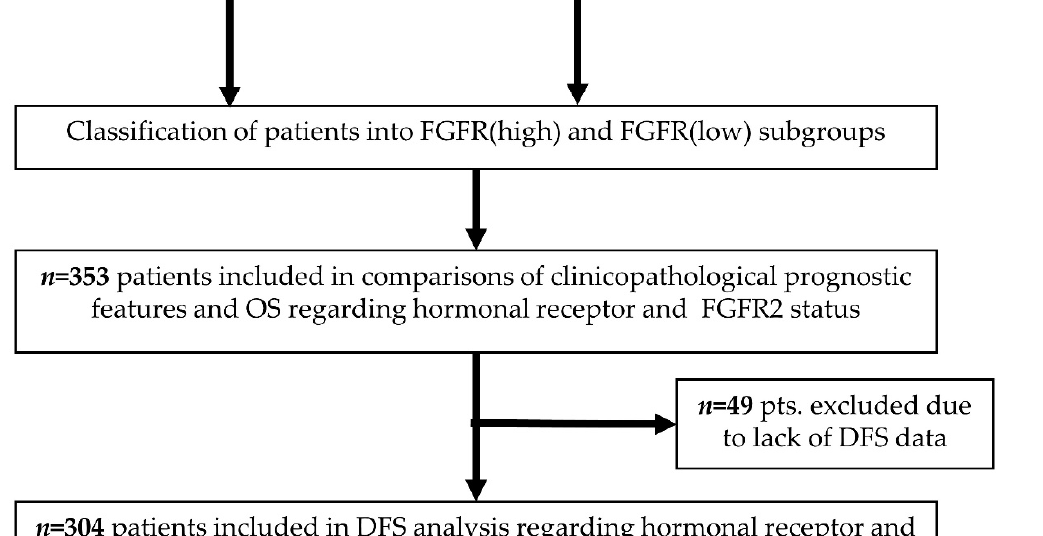
Figure 1. Flowchart of the study design with indication of numbers of patients from the original cohort included in every analysis. IDC—invasive ductal carcinoma, ER—estrogen receptor protein status, PR—progesterone receptor protein status, IHC—immunohistochemistry, FGFR2—fibroblast growth factor receptor 2 protein, PR(mol)—molecular signature progesterone receptor-dependent genes, OS—overall survival, DFS—disease-free